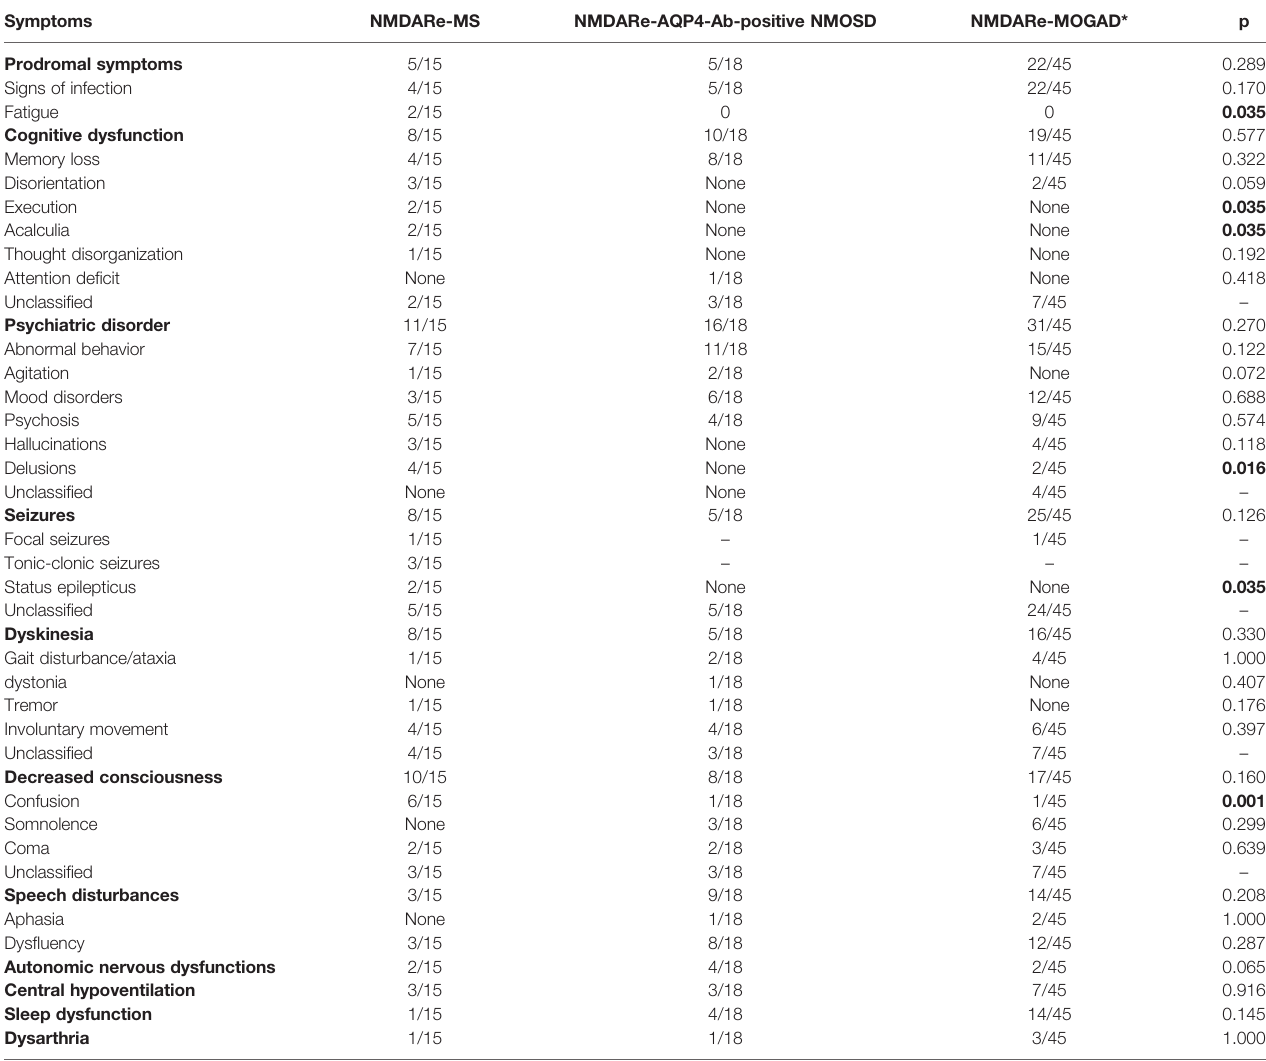
TABLE 2 | Summary of clinical symptoms of the three groups.